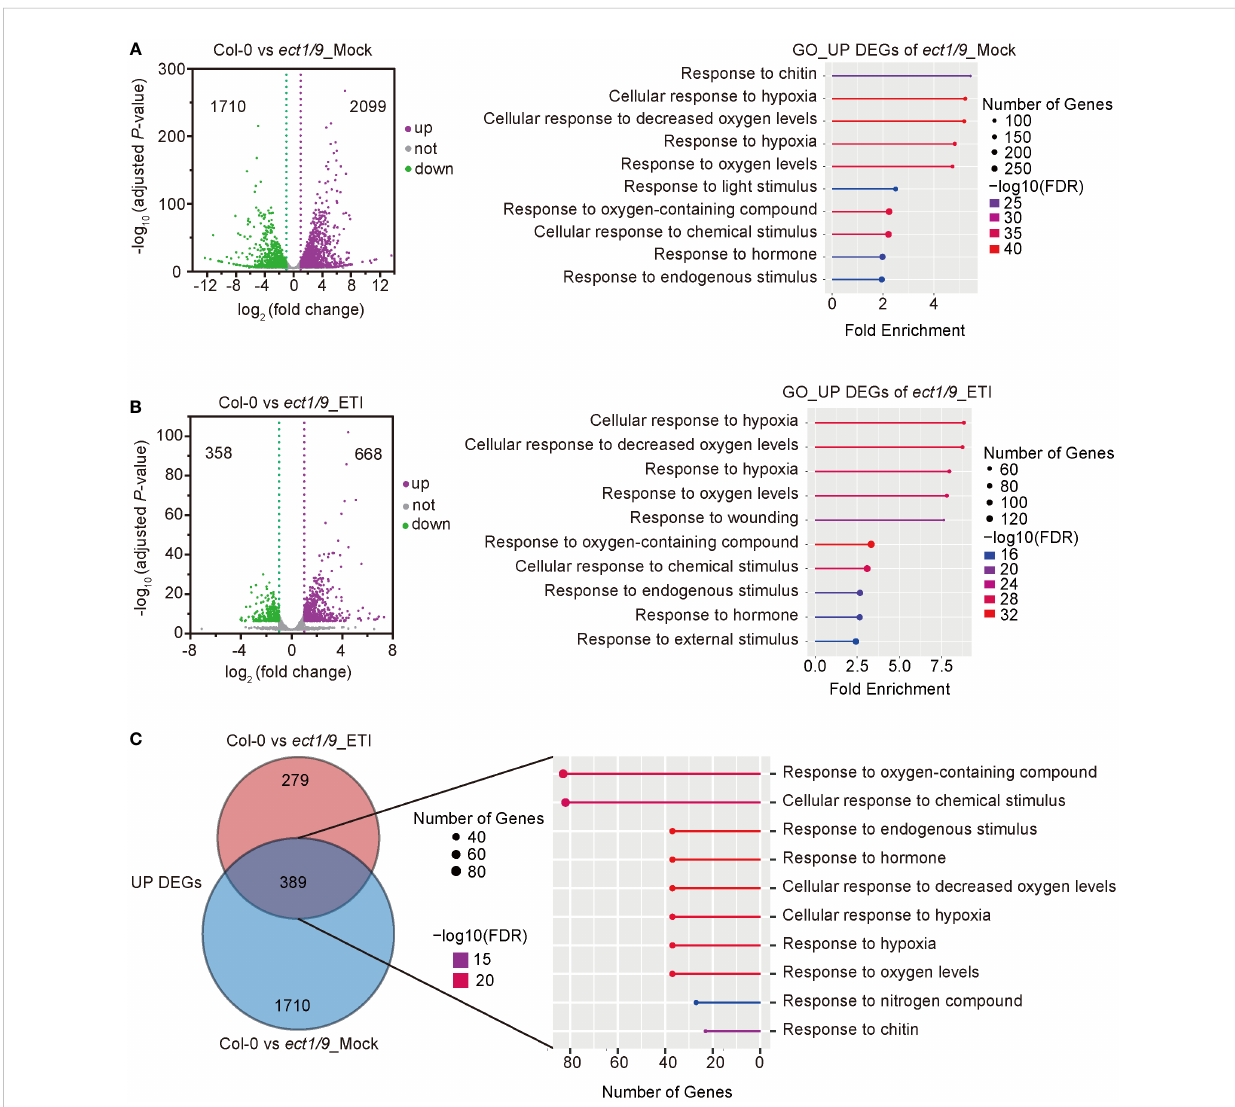
FIGURE 5 RNA-seq analysis of ect1/9 . (A) Analysis of ect1/9 without ETI activation (Mock). The volcano plot shows differentially expressed genes (DEGs) based on two replicates of RNA-seq data in the ect1/9 double mutant compared with the wild type Col-0. Violet dots represent up-regulated DEGs, green dots represent down-regulated DEGs, and gray dots represent the genes with no signi fi cant change. The y-axis shows -log 10 (adjusted p -value), while the x-axis shows log 2 (fold change) values. Right, the top 10 signi fi cantly enriched Gene Ontology (GO) terms of up-regulated DEGs in the ect1/9 double mutant (FDR < 0.05). The color of the square indicates the signi fi cance of the term. The size of each point corresponds to the gene number of each GO term. (B) Analysis of ect1/9 with ETI activation by Psm ES4326 (AvrRpt2). (C) Venn diagrams show the overlaps between up- regulated DEGs in the ect1/9 double mutant with (ETI) and without (Mock) Psm ES4326 (AvrRpt2) treatment. The numbers of overlapping DEGs were further used for GO analysis. The top 10 signi fi cantly enriched GO terms shared of up-regulated DEGs were shown in the right